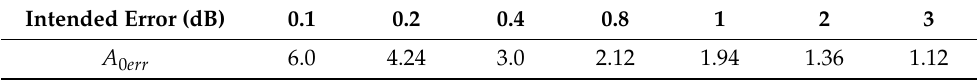
Table 1. Values of A 0 err with respect to the intended prediction